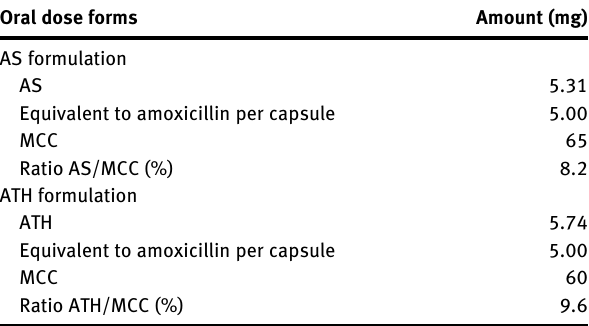
Table  : Composition of amoxicillin sodium (AS) and amoxicillin trihydrate (ATH) based formulations compounded in the present study.